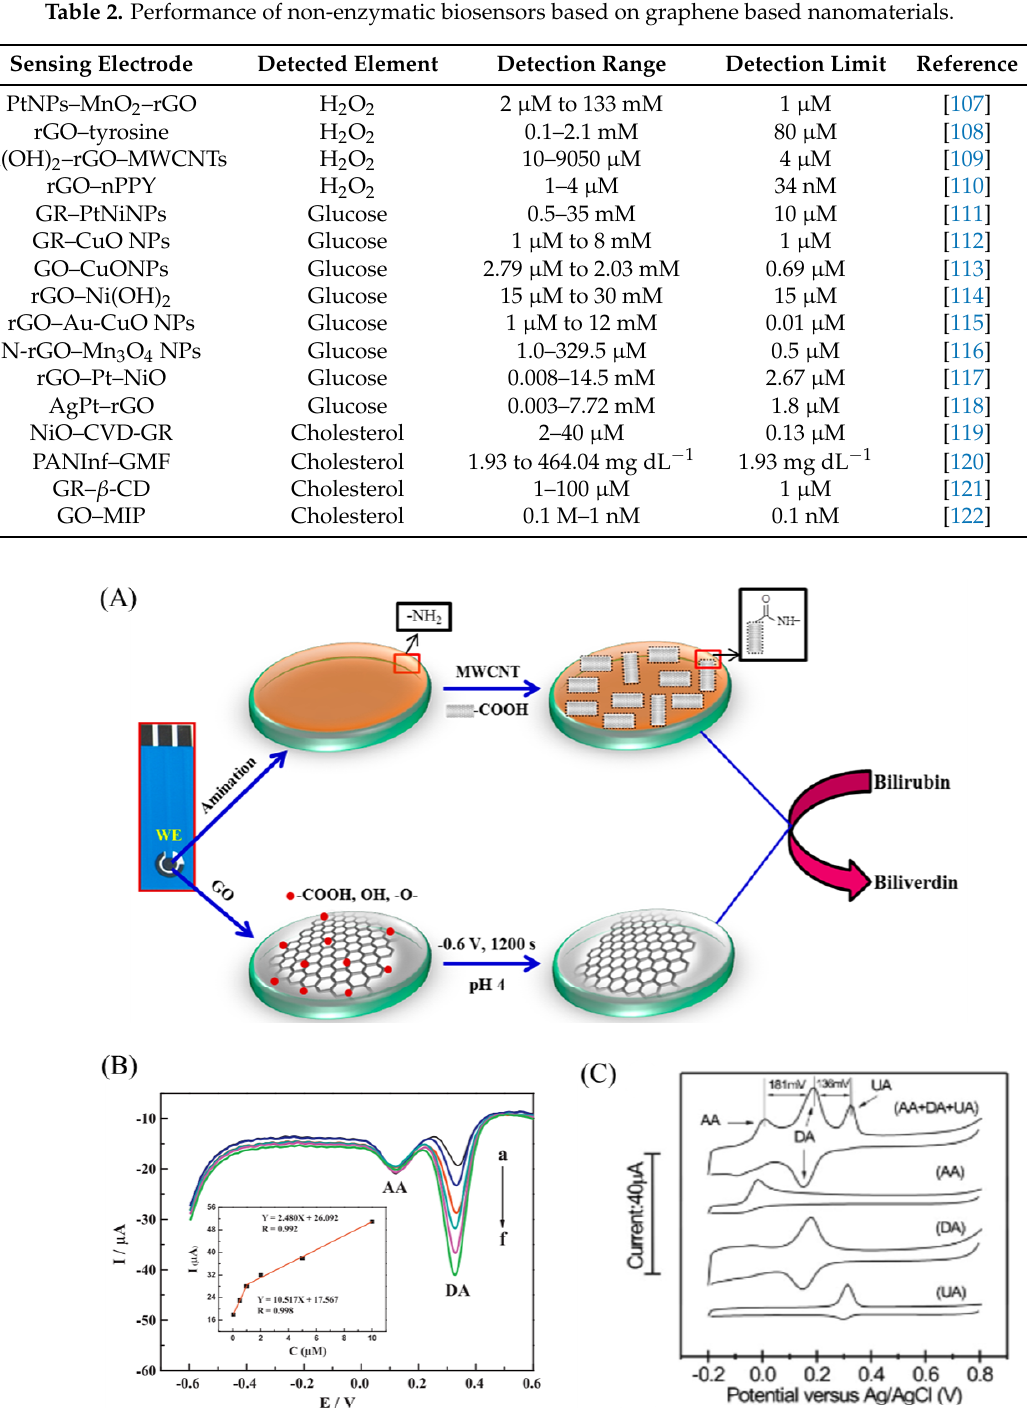
Figure 6. ( A ) Schematic showing the preparation of the MWCNT based (top row) or electrochemically reduced graphene oxide (ErGO) based (bottom row) bilirubin sensors. ( B ) Differential pulse voltammograms of DA (from a to f: 0.05, 0.5, 1, 2, 5 and 10 µ M) at Gr/p-ABA/GCE in the presence of 100 µ M AA. Inset: calibration plots of the oxidation peak current versus different concentrations of DA. ( C ) CV profiles of the MGNF electrodes in the solution of 50 mM, pH 7.0 PBS with 1 mM AA, (cid:13) 0.1 mM DA, and 0.1 mM UA. Figures reproduced with permission from: ( A ) [42], MDPI c ; ( B ) [104], (cid:13) (cid:13) Elsevier c ; and ( C ) [105], Wiley Interscience c